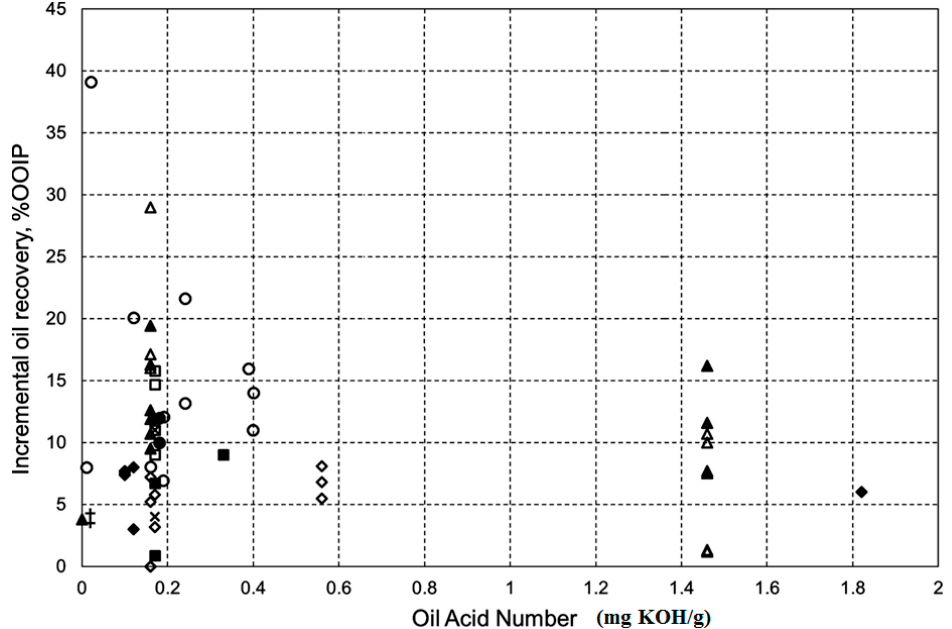
Figure 2. Collection of data showing lack of correlation between improved oil recovery and acid number (AN) of the crude oil (see more information about the plotted data in Jackson et al. [75]).